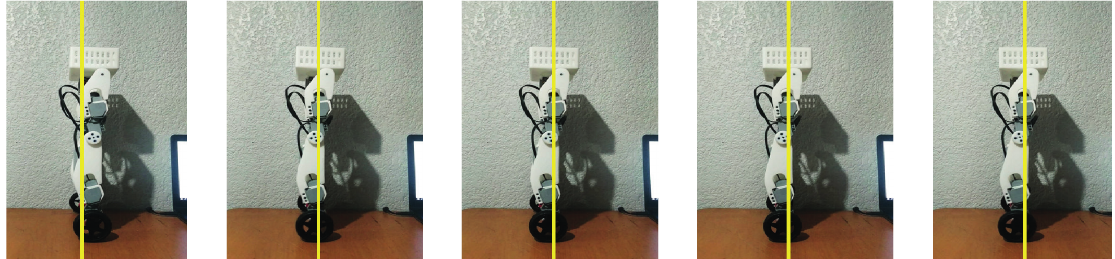
Figure 11. Mobile robot